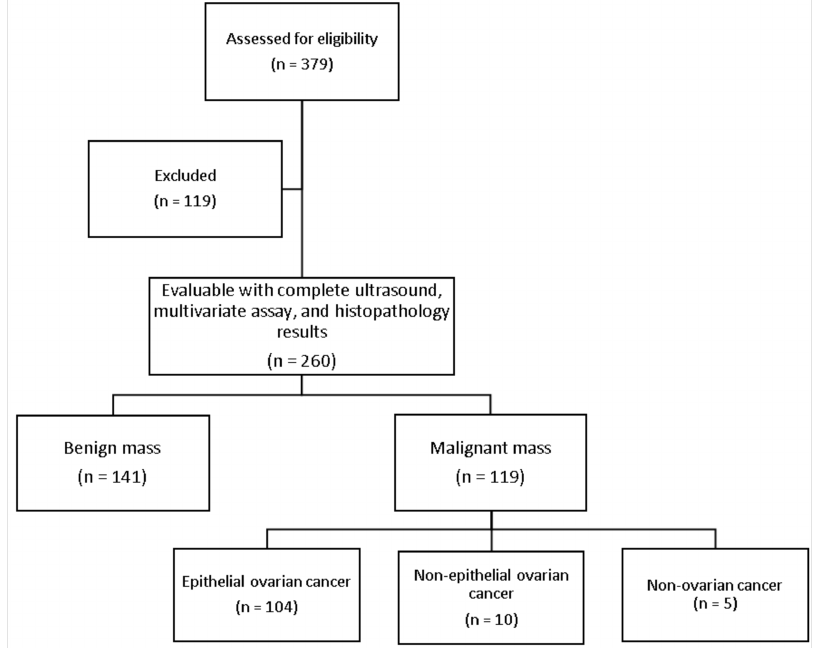
Figure 2. Flowchart showing the final sample size of the participants for this